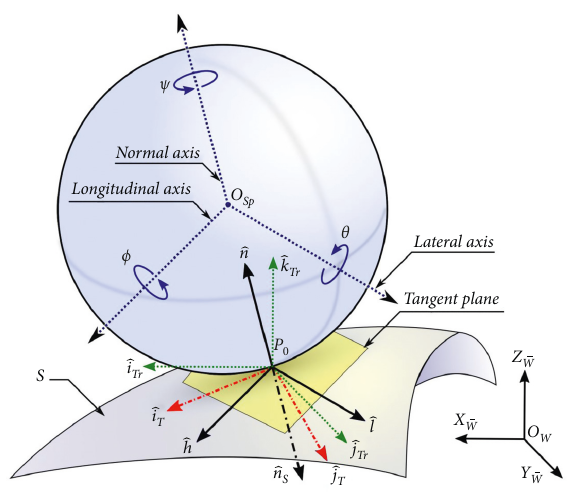
Figure 1: Schematic diagram of reference frames and kinematic parameters that are used to derive kinematics equation of the rolling sphere on a 3D surface S